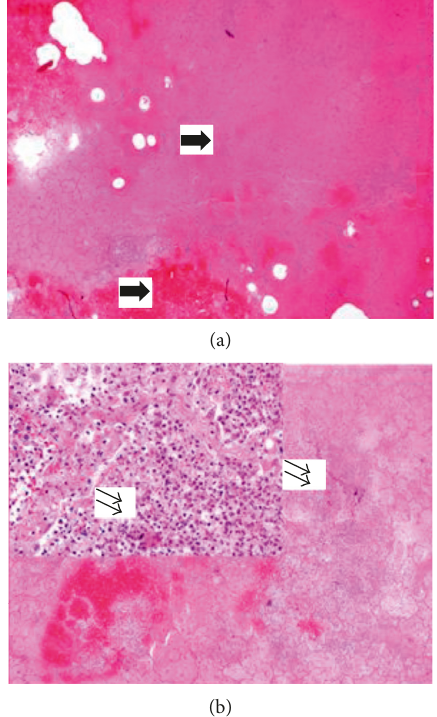
Figure 6: Complete necrosis of the lung with extensive haemor- rhage and absceding bronchopneumonia. (a) Completely necrotic lung parenchyma with extensive intra-alveolar haemorrhage. The lung parenchyma is visible as a shadow. (b) An intra-alveolar infiltration by neutrophilic granulocytes (double arrows), focally with abscess formation (haematoxylin and eosin, original mag- nification 4x insert, original magnification 20x).